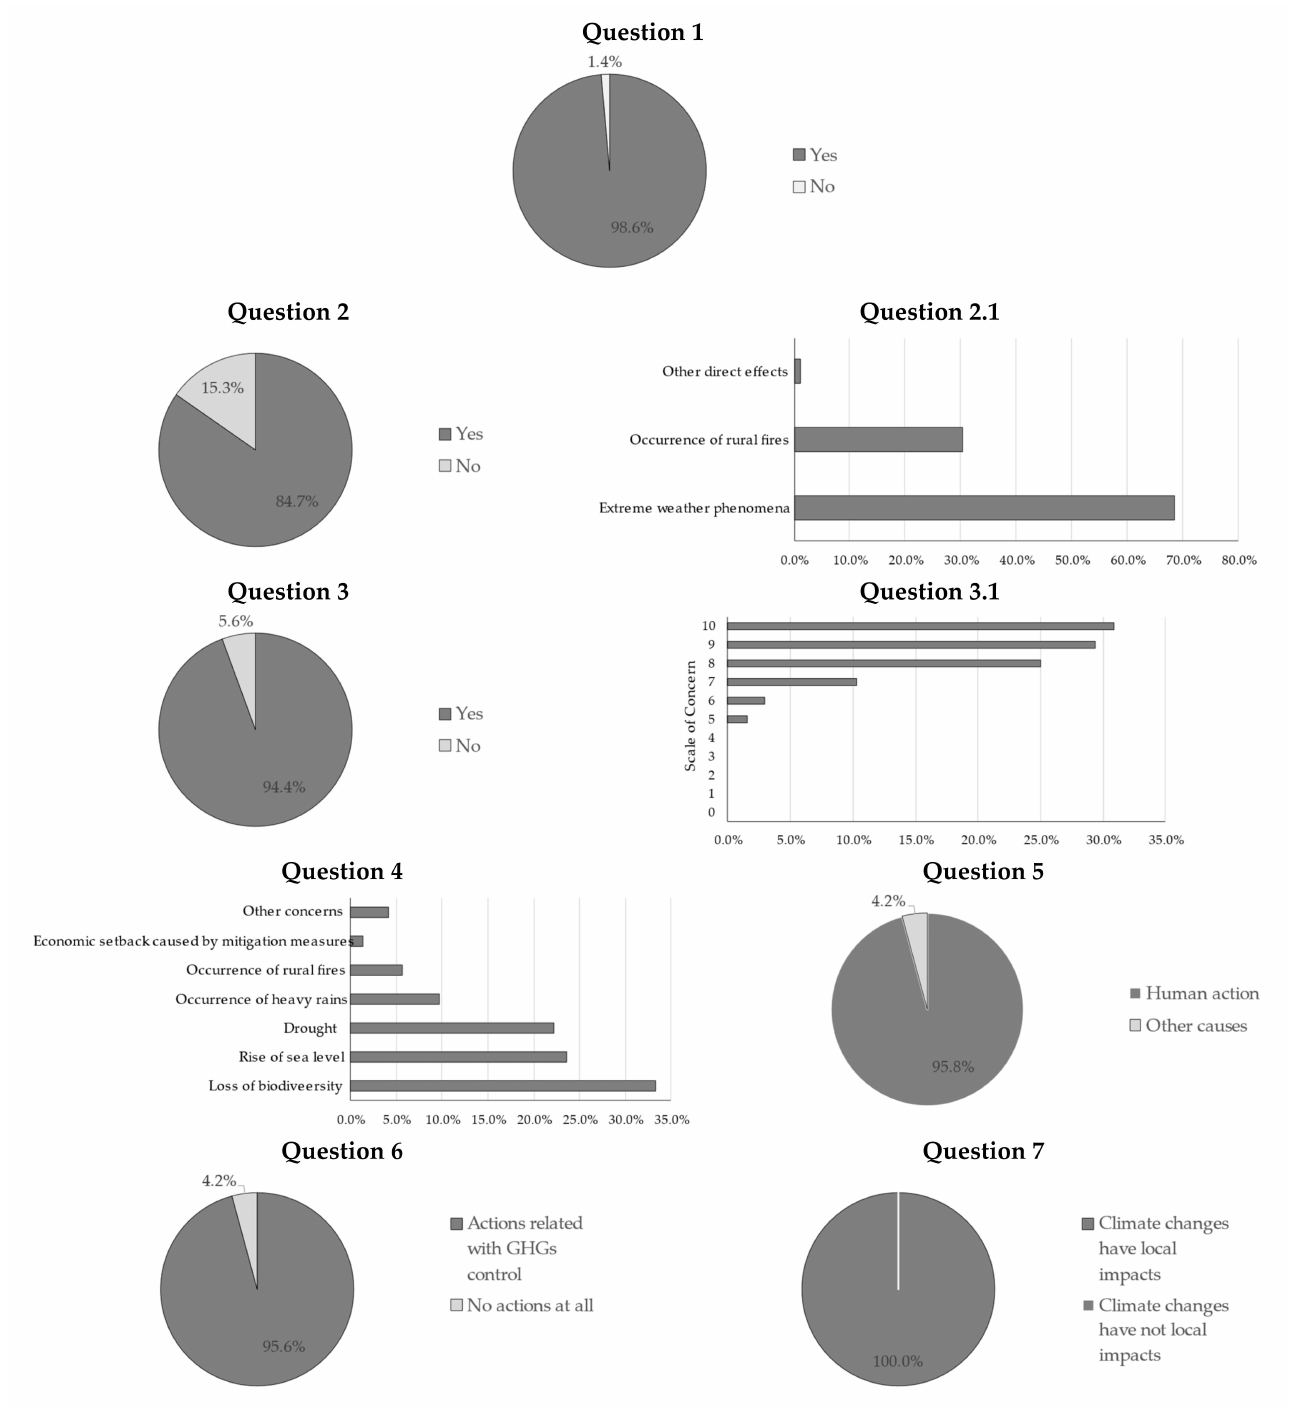
Figure 1. Summary of survey